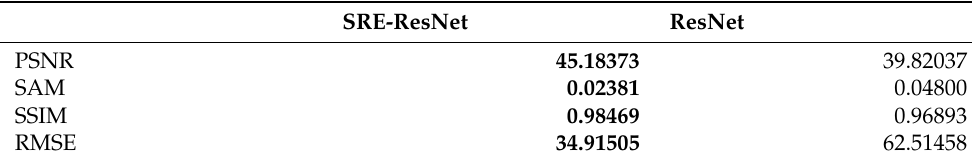
Table 2. Quantitative fusion results of SRE-ResNet and ResNet for Dataset I.